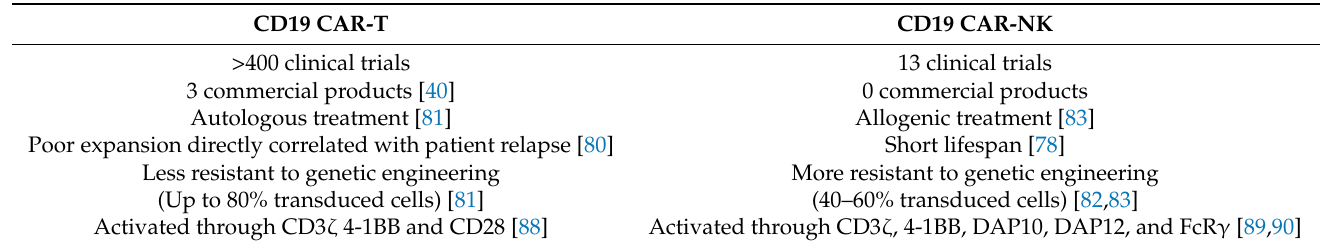
Figure 2. Mechanism of action of NK cells and T cells. On the left, NK cells are killing a tumor cell, as inhibitory receptors do not encounter self-recognition in other cells. NK cells secrete granulocytes such as perforin and granzyme in order to kill the tumor cell. On the right, a T cell is being primed for activation by APC and cytokine stimulation. An effector T cell kills the tumor cell by secreting granulocytes and other cytokines into the tumor microenvironment. Table 2. Most noteworthy differences between CAR-T based treatments and CAR-NK based